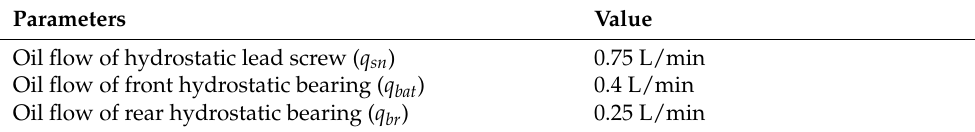
Table 4. Parameters of oil flow.